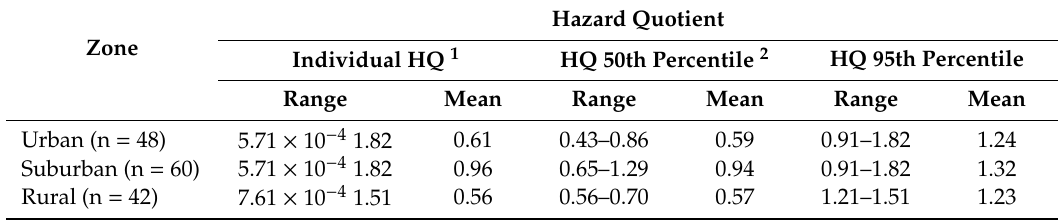
Table 5. Non-cancer risk presented by hazard quotient (HQ) classified by job function (n = 150). Hazard Quotient Job Function Individual HQ 1 HQ 50th Percentile HQ 95th Percentile Range Mean Range Mean Range Mean Fueling (n = 137) 5.71 × 10 − 4 –1.82 0.80 0.51–1.03 0.72 0.91–1.82 1.28 Cashier (n = 13) 5.71 × 10 − 4